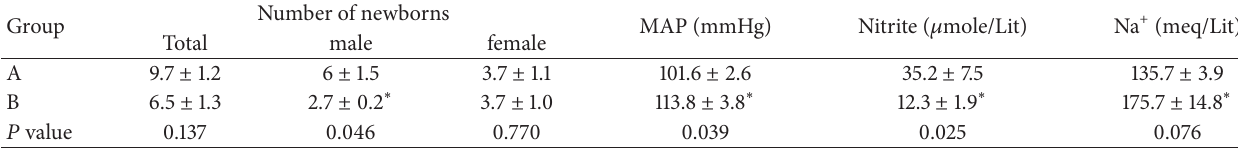
Table 1: Number of newborns, MAP, and serum nitrite level of mother with salt and tap water 30 days after delivery. Number of newborns Group